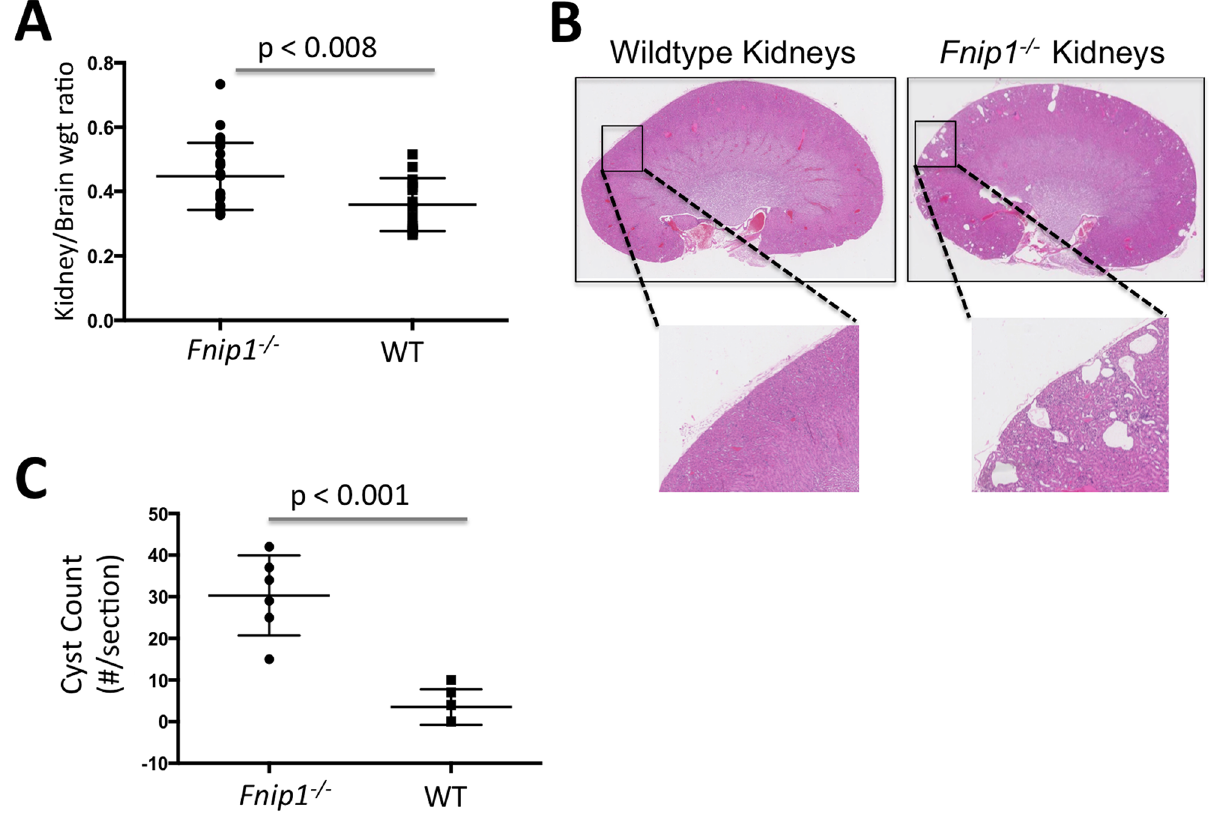
Fig 1. Loss of Fnip1 results in increased kidney size and cyst formation. (A) Increased kidney-to-brain weight ratio in Fnip1 -/- versus wildtype mice. n = 15 mice per genotype. Shown are means +/- SEM. (B) Representative hematoxylin and eosin stained histology sections of Fnip1 -/- and wildtype kidneys. Fnip1 -/- mice develop cysts and microcysts in the renal cortex. (C) Graph showing cyst counts, as determined by a blinded counter, of 12–18 week-old Fnip1 -/- and WT mice (n = 6 per group). (cid:3) p-values are shown.